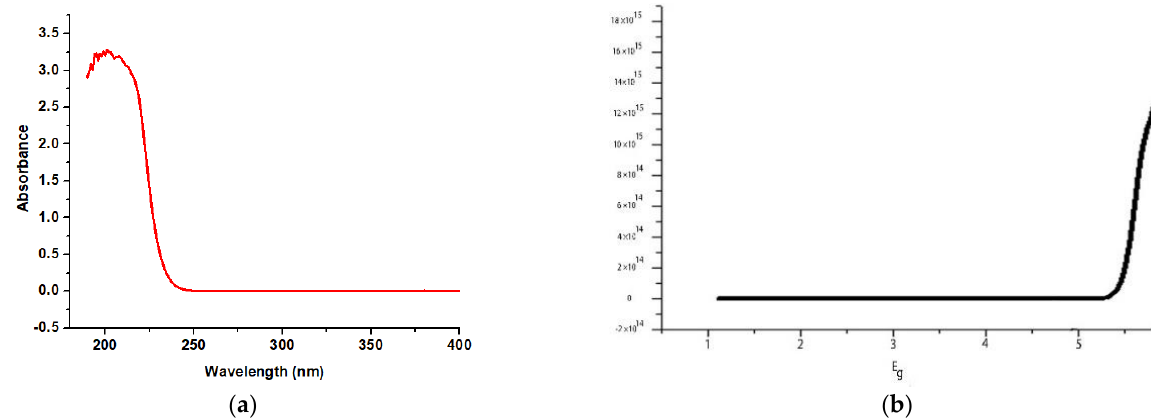
Figure 5. ( a ) Absorption spectra (UV-Vis) of the La 2 ZnO 4 nanocomposite ( b ) Tauc plots of (αhν) 2 versus hν of the La 2 ZnO 4 nanocomposite.